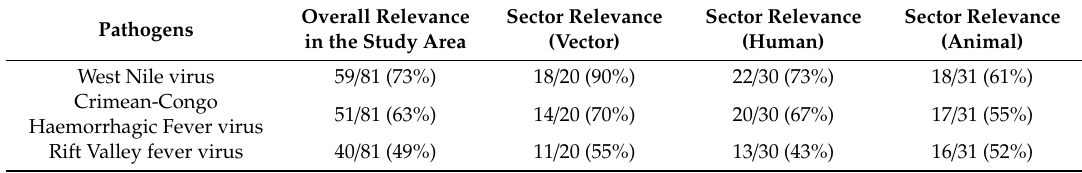
Table 2. Zoonotic pathogens perceived relevance in the study area and by sectors.